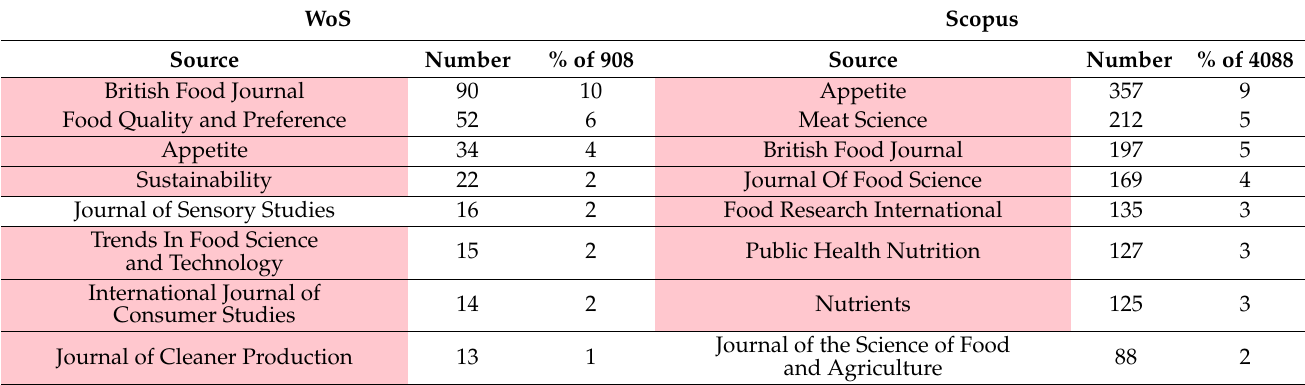
Table 1. Number of records for the top 40 most productive sources in the WoS and Scopus databases.